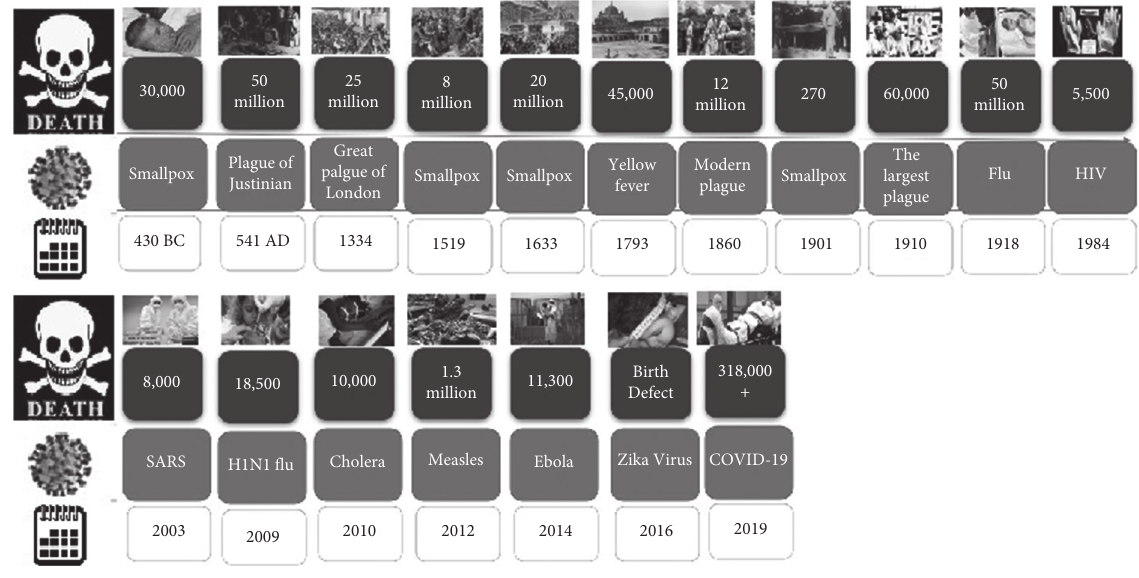
Figure 1: The history of epidemics [2,